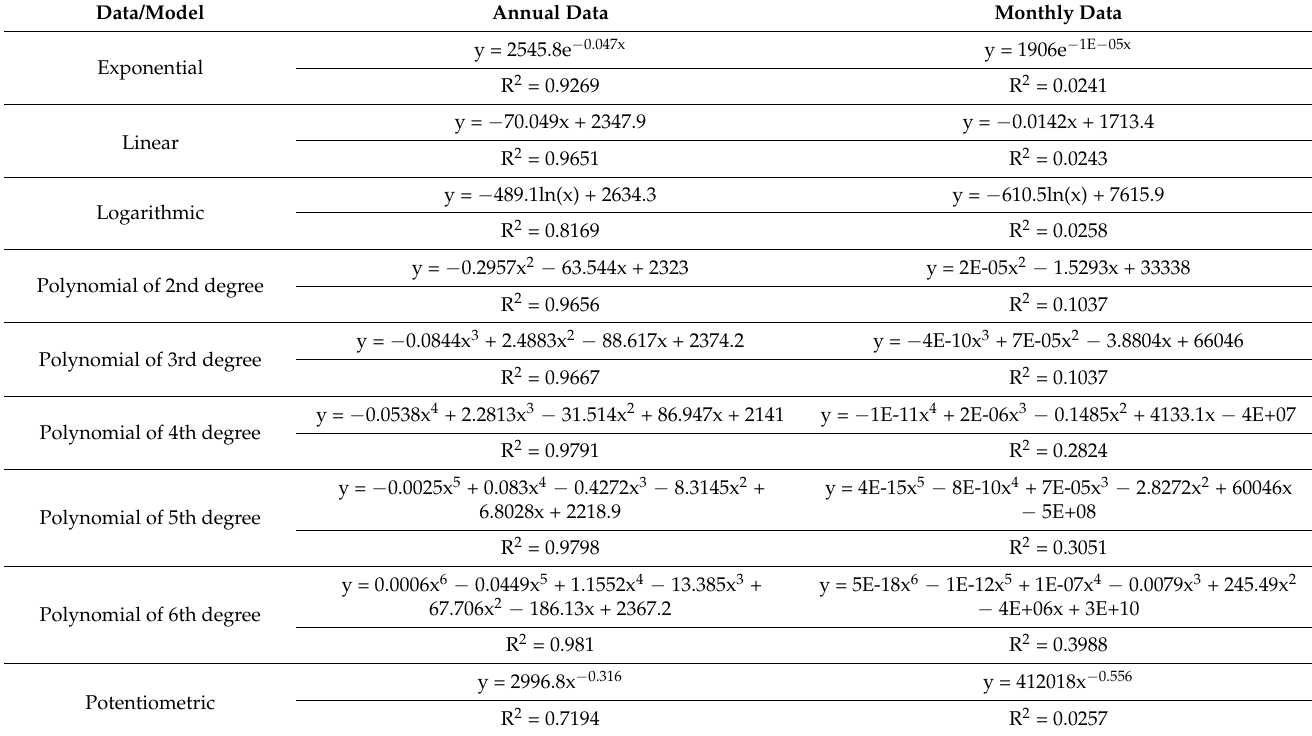
Table A13. Trend models for the Holy Cross